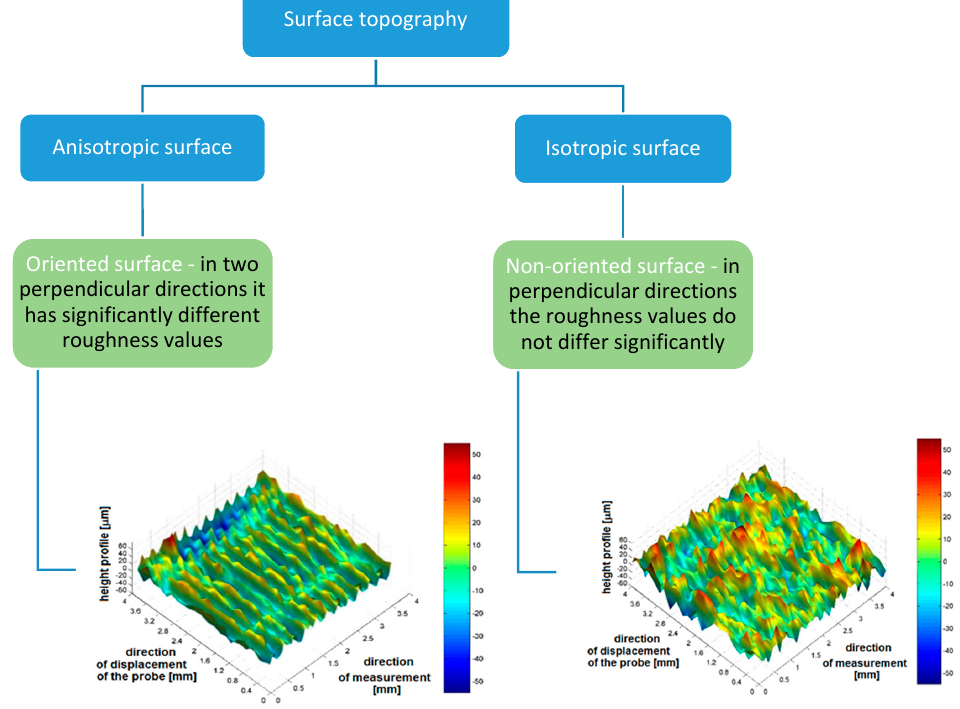
Figure 3. The classification of surfaces in terms of surface topography.